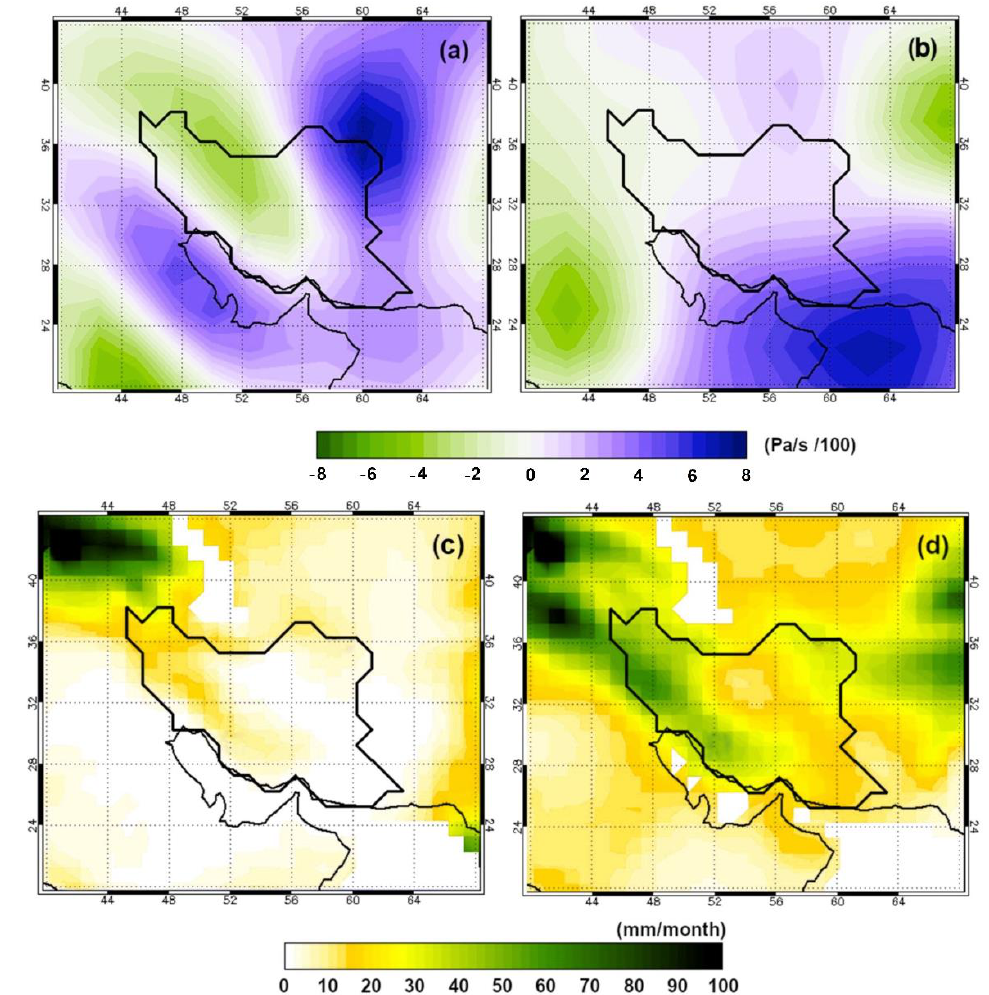
Figure 2. Spatial distribution of atmospheric stability ( ω ) ( a , b ) derived from NOAA website [22] and precipitation amount ( c , d ) over Iran derived from CRU3.23TS datasets [23] for the dry and wet periods, respectively.